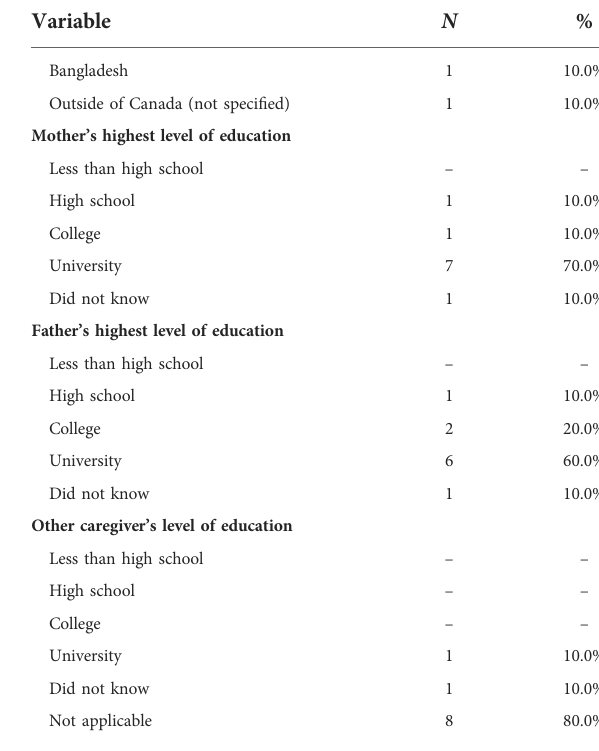
TABLE 1 Demographic characteristics of individuals who participated in the adolescent advisory group ( N